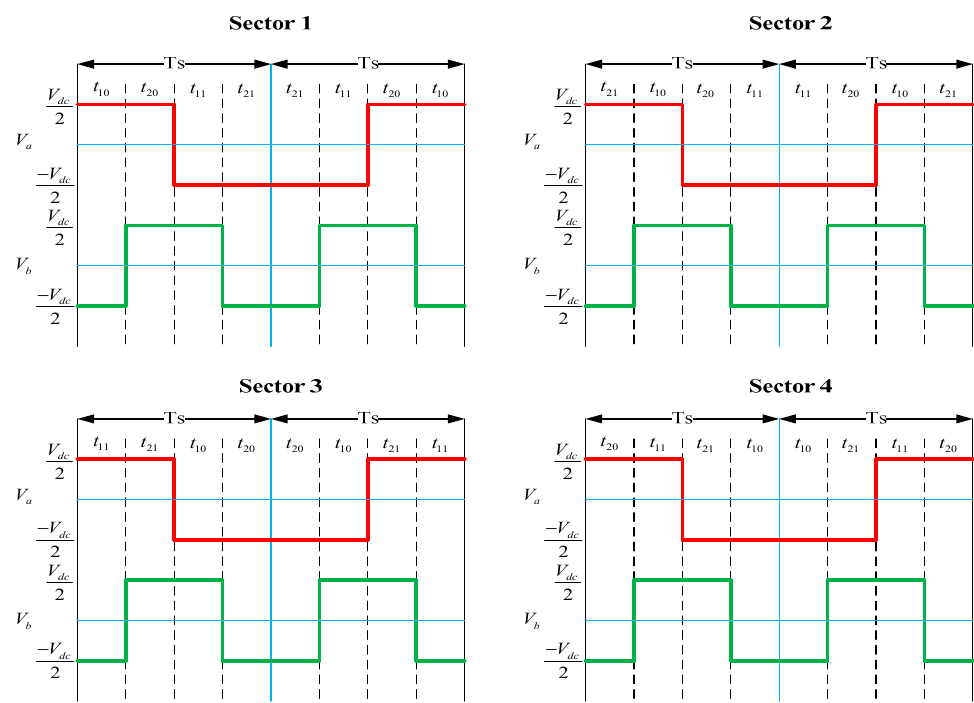
Electronics 2022 , 11 , 187 Figure 5. 2 ϕ -inverter output voltages by the advanced SVM symmetrical modulation. Figure 5. 2 φ -inverter output voltages by the advanced SVM symmetrical modulation. In the main sector, the reference vector begins at V 1 and finishes at V 4 in the diagonal sector with the time durations t 10 and t 21, respectively. This rule is applied on all sectors because the main vector can begin at another space vector such as V 2 , V 3 or V 4 , reserving the symmetry during 2 T s . From Figure 5, it is noted that two inverter legs carry out either one switching for V a or two switching for V b regularly during 2 T s to determine the suitable PWM output voltages. For the conventional SVM technique, these waveforms are difficult to implement on hardware platforms because, according to the sector number, the switch- ing operations during 2 T s are changed irregularly, as illustrated in Figure 6.